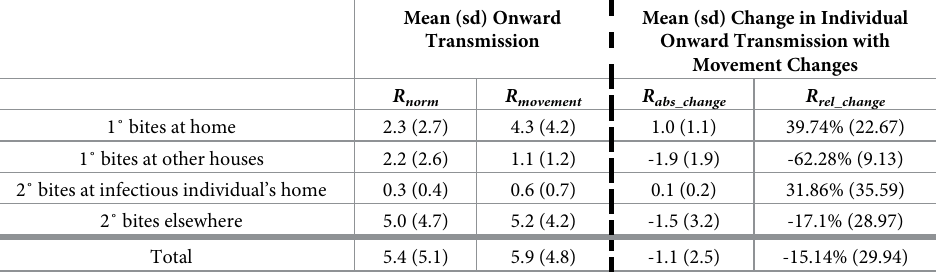
R norm values were calculated using an individual’s healthy movement patterns, while R movement values accounted for changes in mobility throughout infectiousness. Changes in R -values due to mobility inclusion were calculated for each individual as a raw number ( R abs_change ) and as a percent of R norm value ( R rel_change ). Overall R -values were listed, as well as R -values based on only primary bites occurring at home or at other houses.